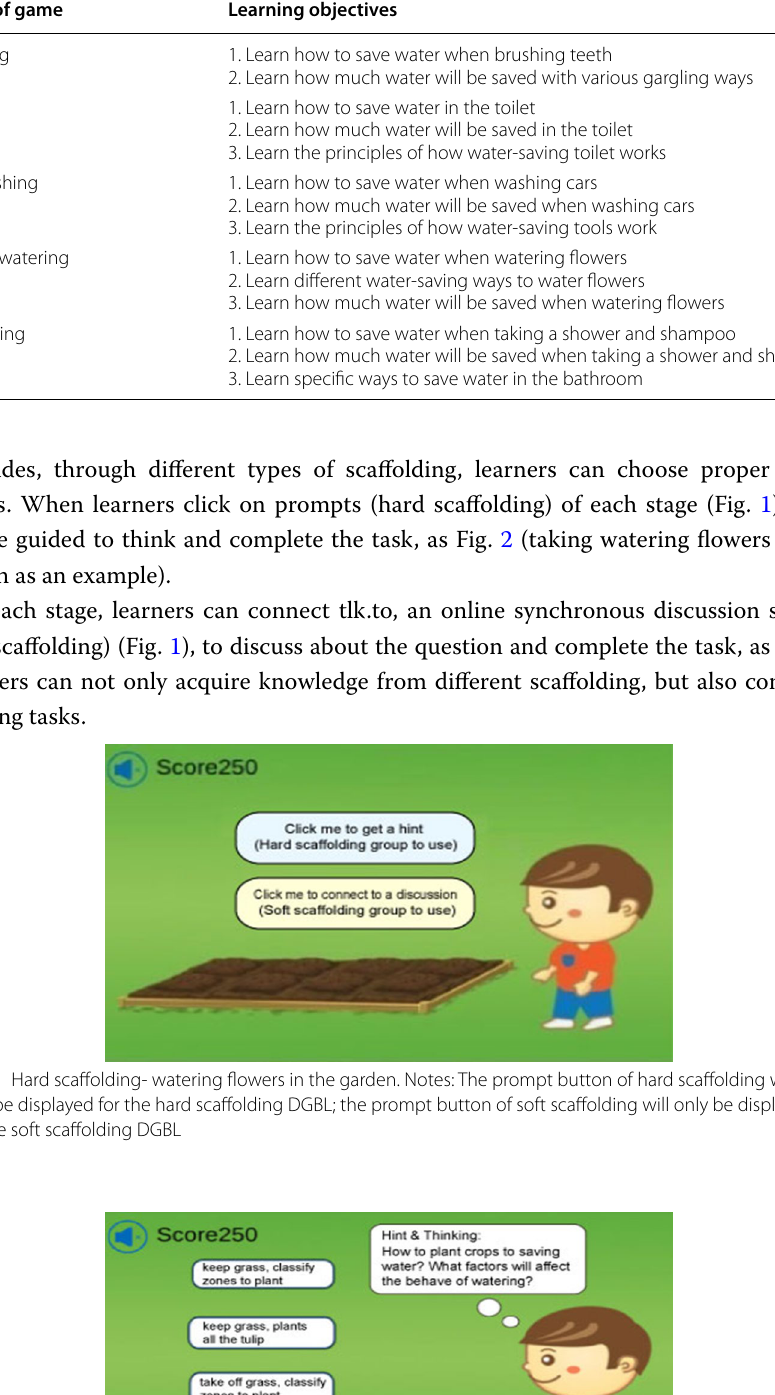
Table 2 Learning content in each stage of the DGBL material Stage of game Learning objectives